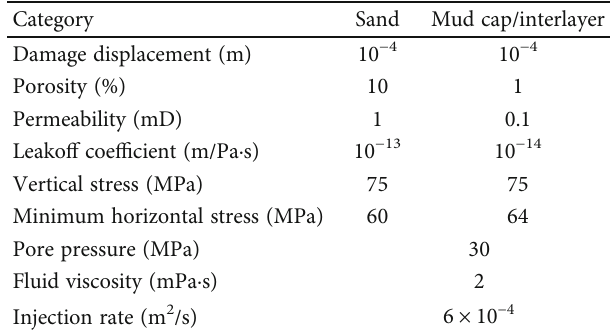
Table 2: Basic parameters for simulation.